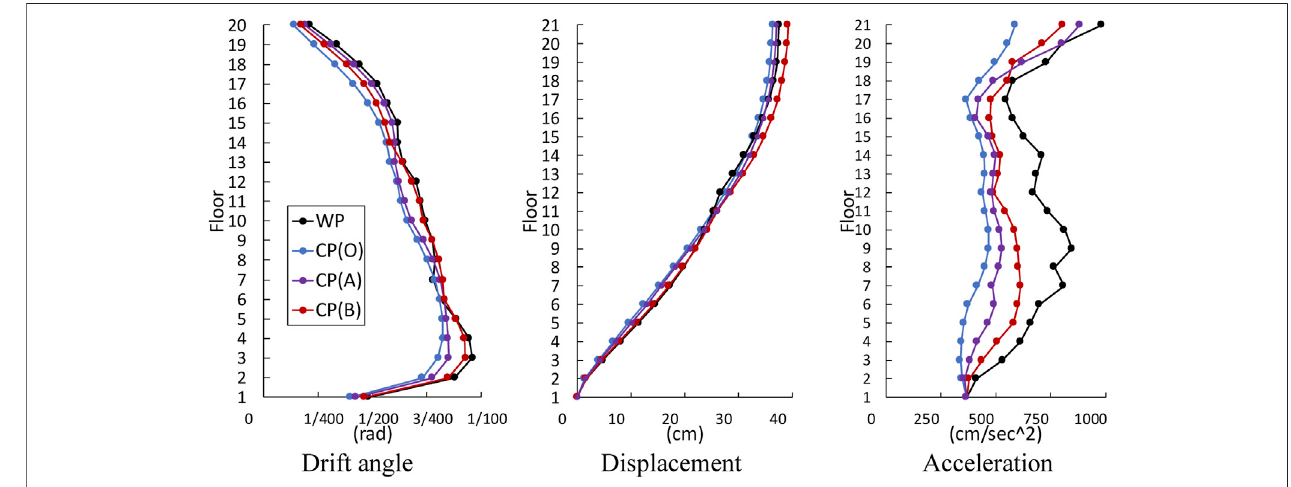
FIGURE 8 | Maximum response of elastic response history analysis (RHA).